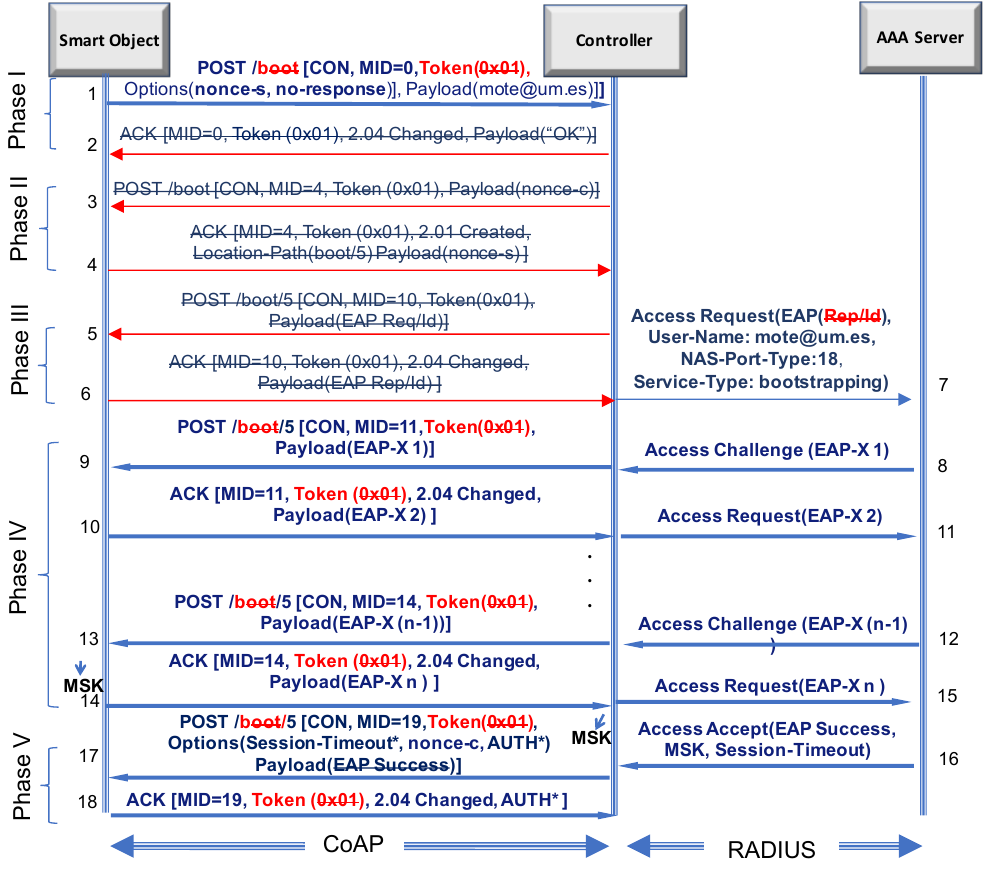
Figure 3. Changes to the original